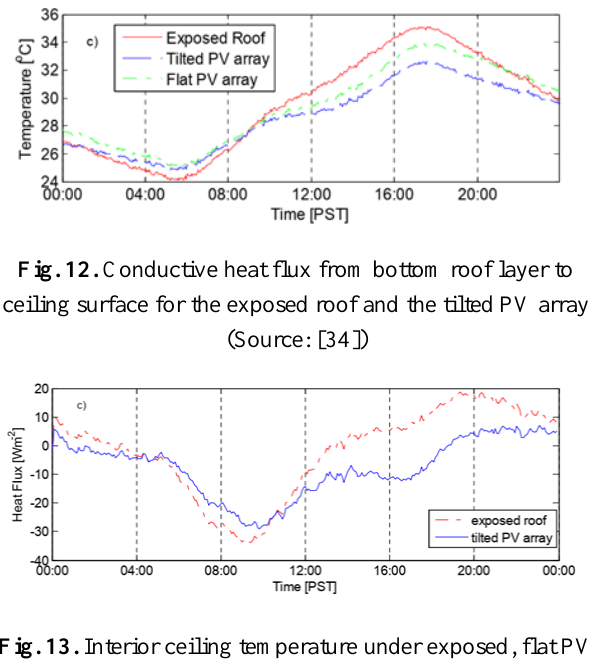
Fig. 13. Interior ceiling temperature under exposed, flat PV and tilted (Source: